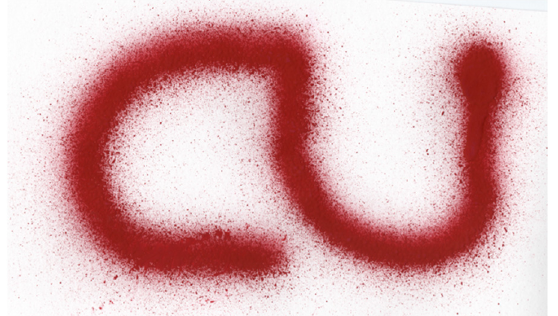
Figure 11. An Application Example